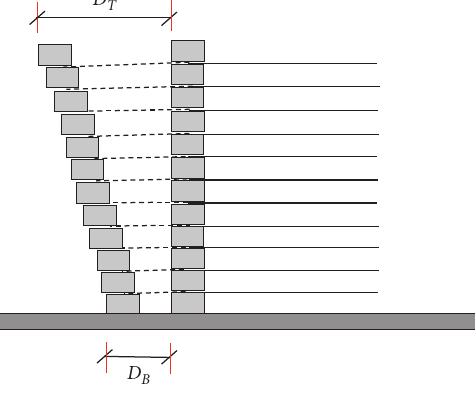
Figure 12: Sliding toe model.